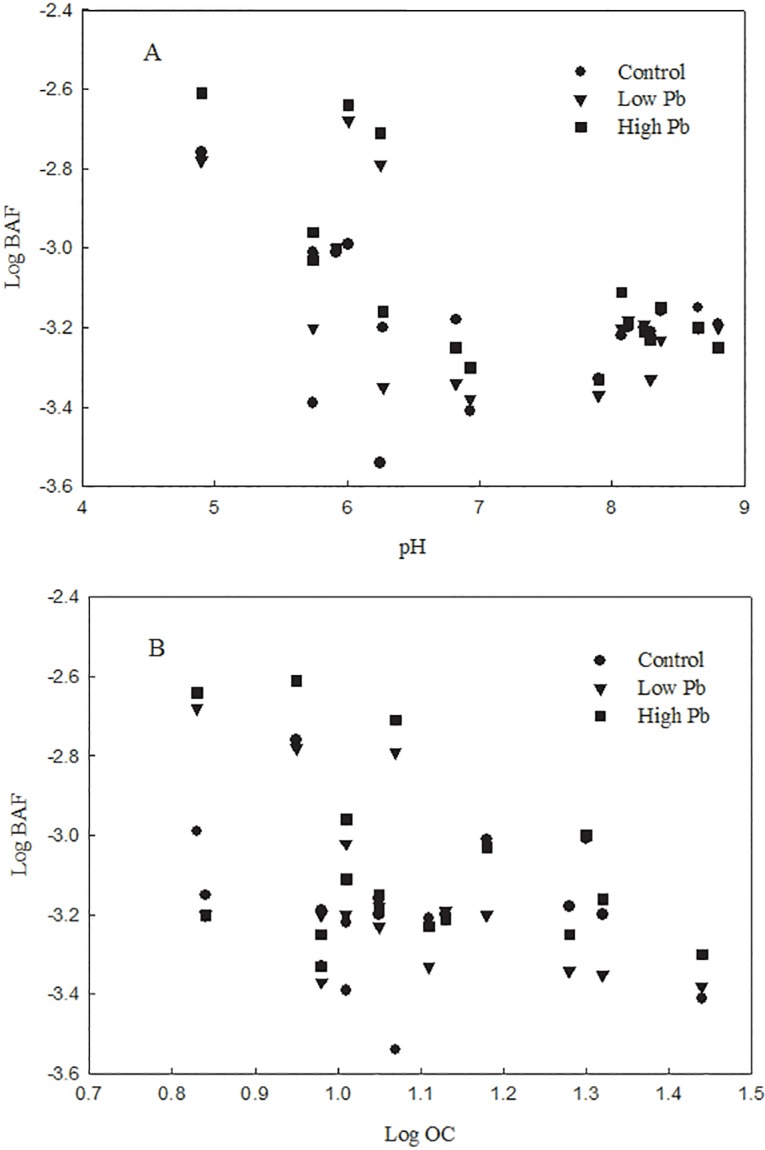
Relationship between Pb accumulation in wheat grain and soil properties (A, pH; B, LogOC).